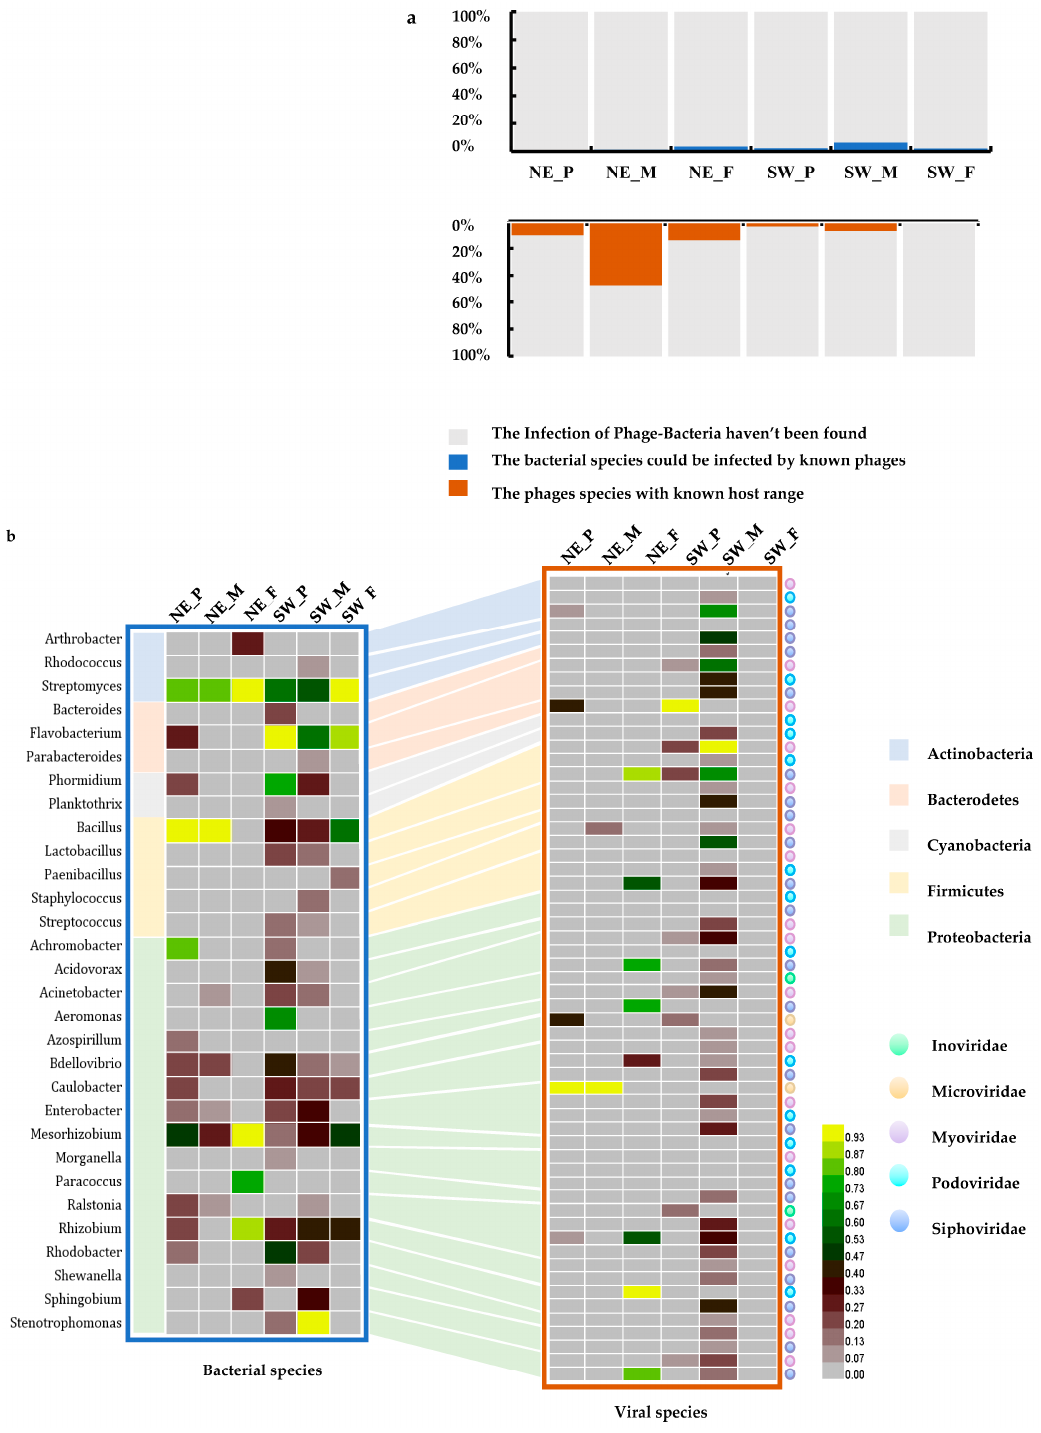
Figure 4. The relationship between bacteria and phages in the six viromes. ( a ) Proportion of bacterial genera and phage species that have a clear relationship of infection based on Virus–host database. ( b ) The distribution of bacterial genera and related phages species. On the left is a bacterial heat map and five different colors represent phylum